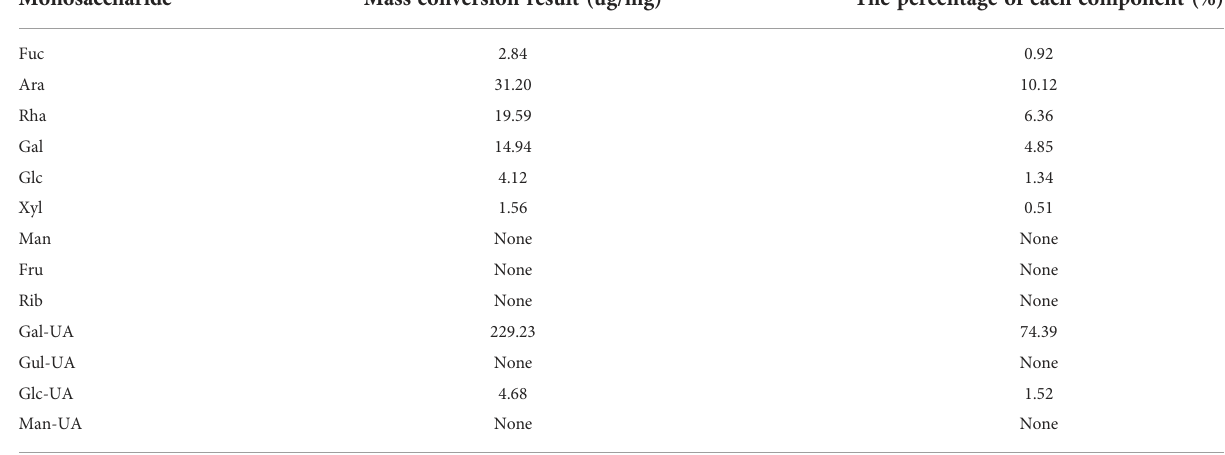
TABLE 1 Monosaccharide composition and ratio of